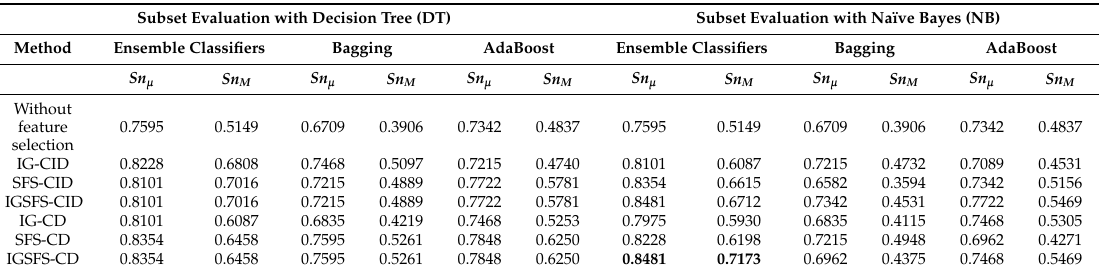
Table 8. Sensitivity comparison using micro-averaging and macro-averaging methods with ensemble learning methods for LC_dataset-II.